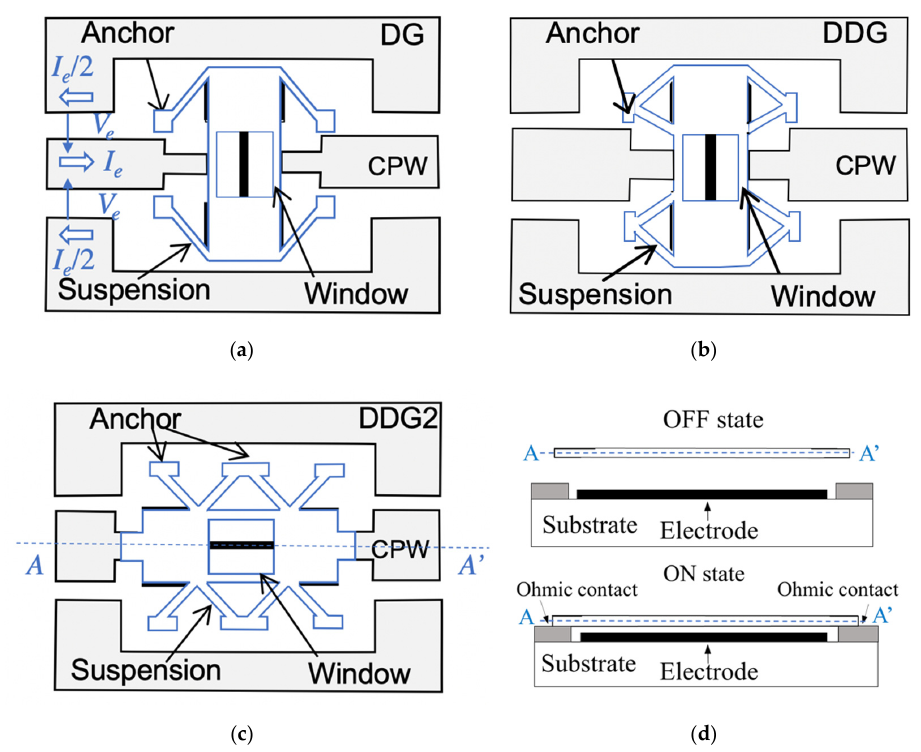
Figure 1. RF ‐ MEMS switch suspension configurations. ( a ) Single diagonal beam (DG); ( b ) double diagonal beam (DDG); ( c ) double diagonal beam suspension with three anchoring points (DDG2). ( d ) Schematic device cross ‐ section showing the membrane in the ON and OFF states.